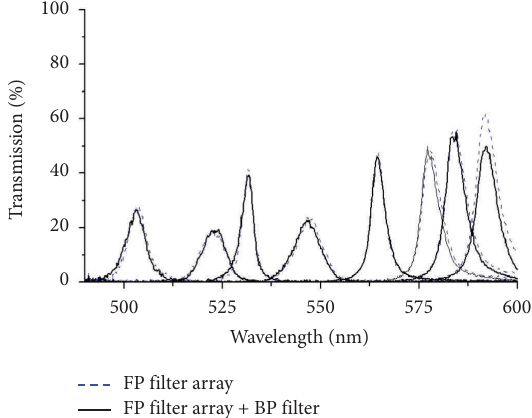
Figure 7: Experimental transmission spectra of the Fabry–P´erot flter array with distinct cavity heights and its combined spectra with the fabricated bandpass flter